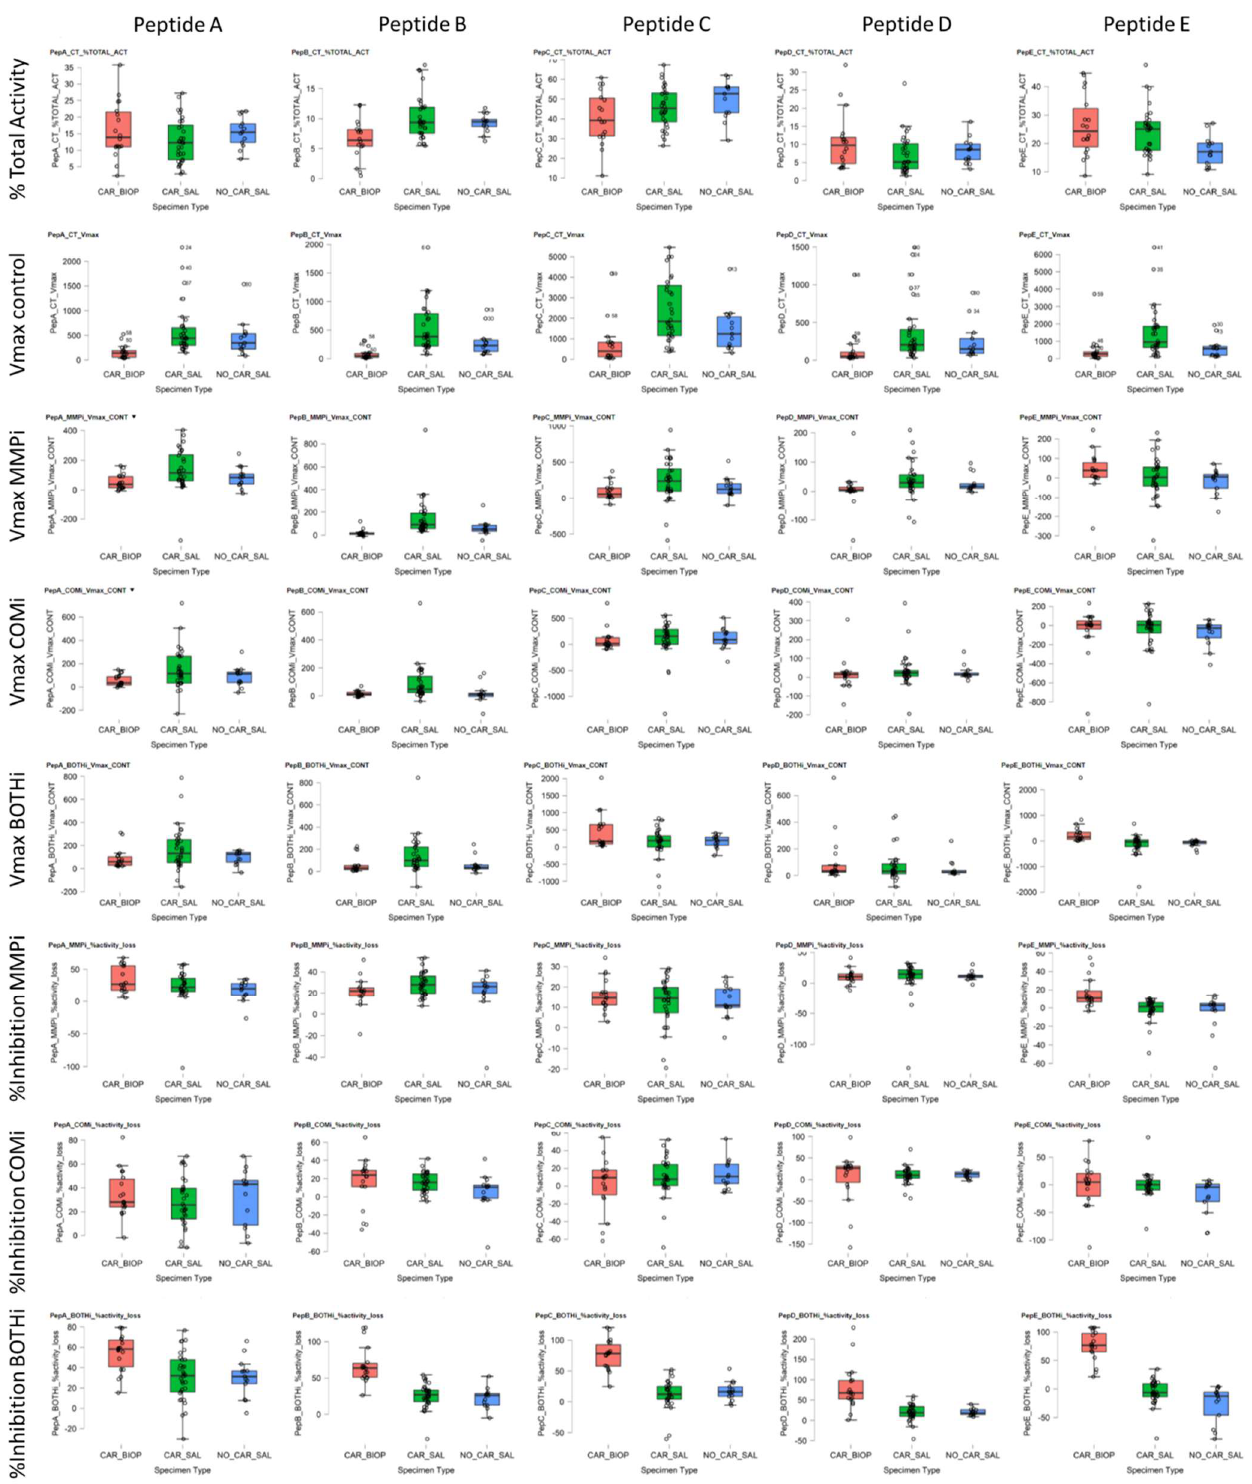
Figure 1. Boxplots for absolute (Vmax) and substrate turnover of peptides used and inhibitors (Vmax), relative (% TOTAL- ACT) substrate utilization across peptides (Peptides A – E ), and contribution of inhibitor-doped samples (% Inhibition). Sample types were WMS, based on caries status (CAR/NO-CAR), and caries biopsy (BIOP) samples for the five peptides studied. Inhibitor data is expressed as Vmax contribution to signal and % inhibition by either Metalloproteases (MMPi), CSC proteases (COMi) or combined MMPi and COMi (BOTHi). relative (%CONT; percentage contribution to turnover; %Inhibition: Percentage inhibition of overall activity).